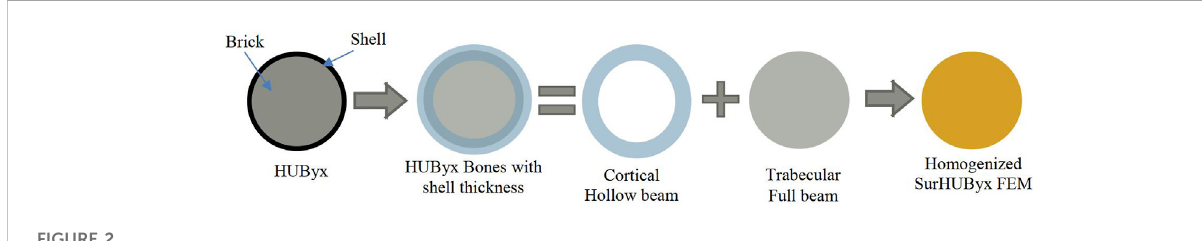
FIGURE 2 Method used for the homogenization of SurHUByx FEM bones.